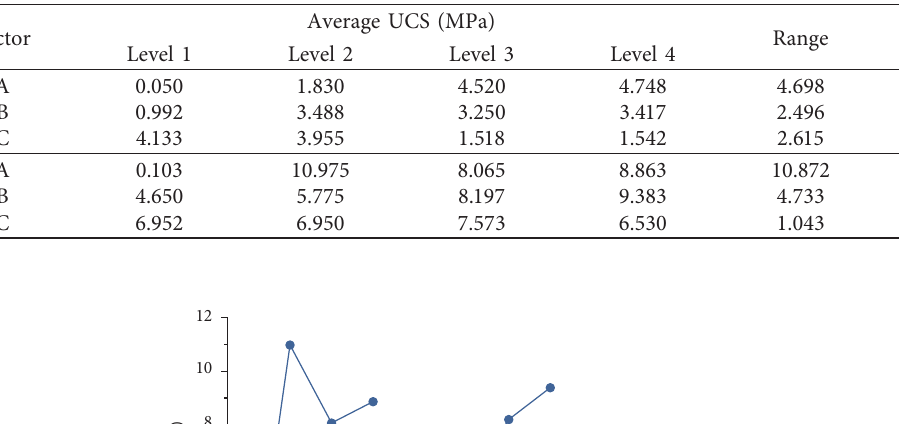
Table 4: Range analysis of UCS.